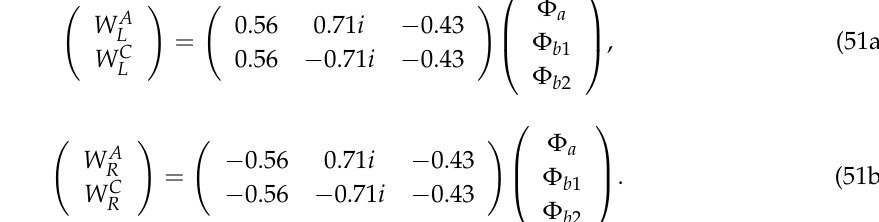
domain, for the [AO] target (solid line) and the [OA] target (dashed line). The vertical dotted